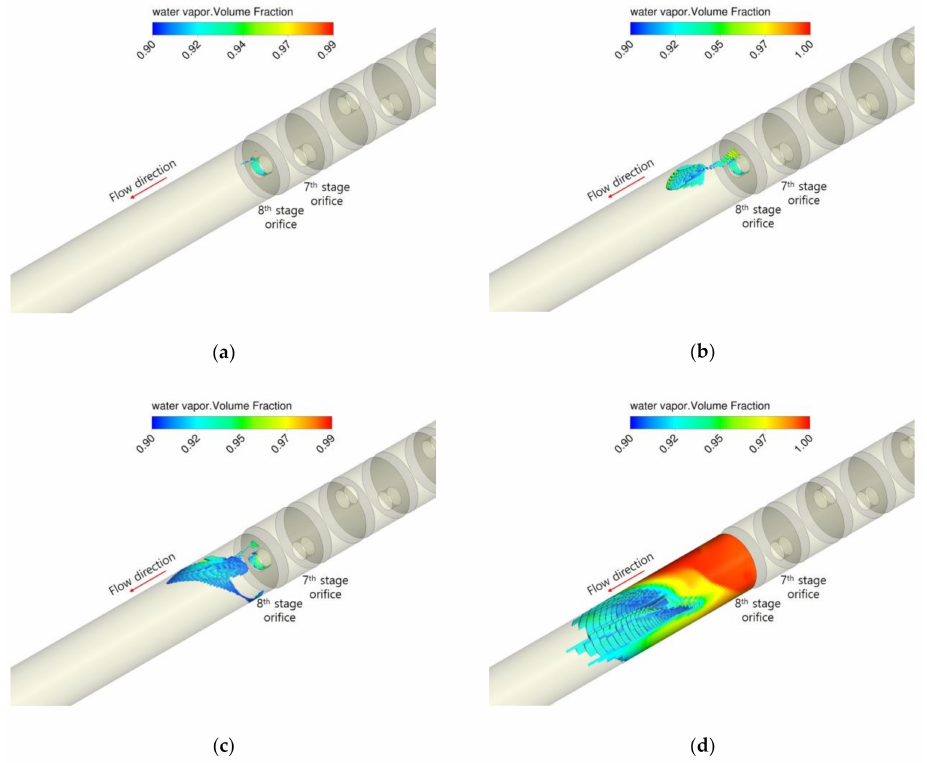
Figure 13. Iso-volume of vapor volume fraction: ( a ) Q in = 34.1 m 3 /h (Re = 2.74 × 10 5 ); ( b ) Q in = 37.0 m 3 /h (Re = 2.97 × 10 5 ); ( c ) Q in = 39.0 m 3 /h (Re = 3.13 × 10 5 ); and ( d ) Q in = 41.5 m 3 /h (Re = 3.33 × 10 5 ).